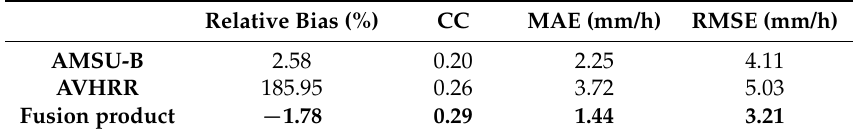
Table 1. Statistical results for the Advanced Microwave Sounding Unit (AMSU-B), the Advanced Very High Resolution Radiometer (AVHRR), and the fusion product. The method with the best performance according to the statistic is denoted. Ground weather radar quantitative precipitation estimation (QPE) is used as reference. CC: correlation coefficient; MSE: mean absolute error; RMSE: root-mean-square error. Relative Bias (%) CC MAE (mm/h) RMSE (mm/h) AMSU-B 2.58 0.20 2.25 4.11 AVHRR 185.95 0.26 3.72 5.03 Fusion product − 1.78 0.29 1.44 3.21